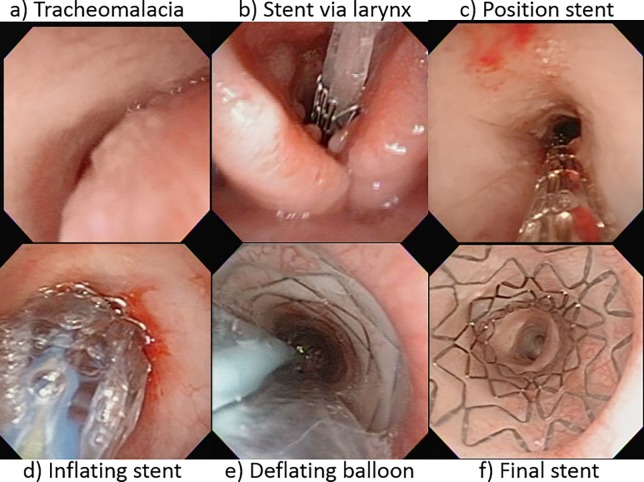
Sequential steps of stent implantation in severe tracheomalacia by flexible endoscopy.a) Tracheomalacia; b) inserting stent via larynx; c) positioning stent; d) inflating the stent; e) Deflating the balloon; f) Final stent.